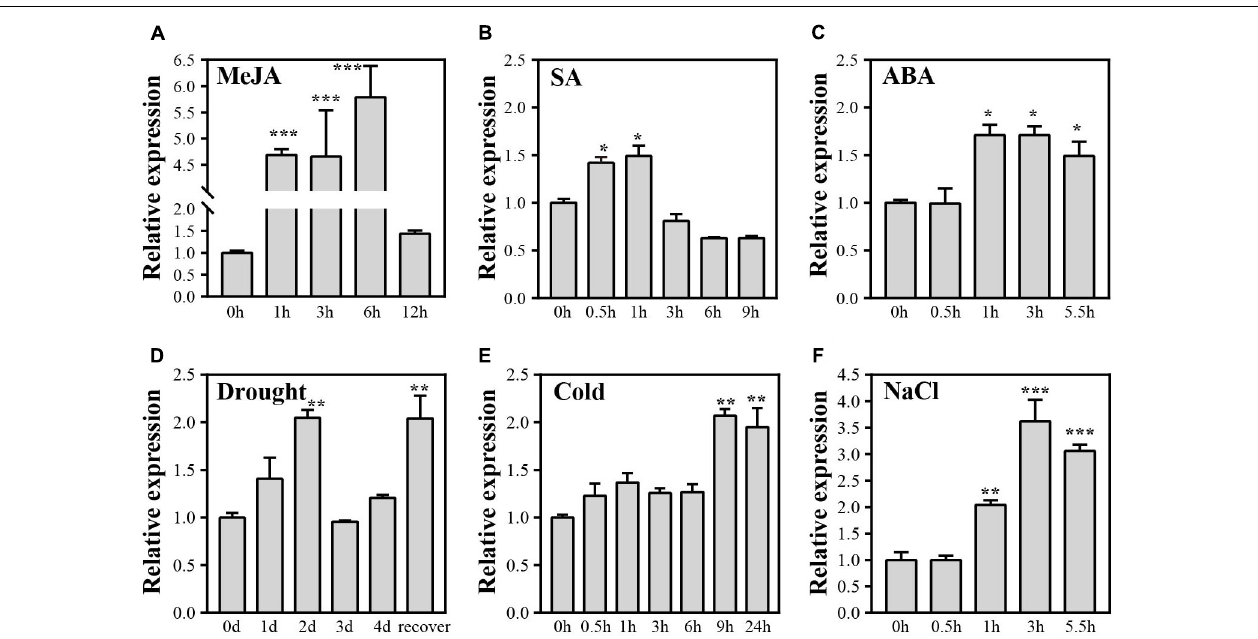
FIGURE 1 | Expression levels of OsJAZ1 under various abiotic stresses and phytohormone treatments. (A–F) Seedlings at the four-leaf stage were subjected to treatment with drought stress, NaCl (200 mmol/L), cold (4 ◦ C), ABA (100 µ mol/L), MeJA (100 µ mol/L), and SA (100 µ mol/L), respectively. Error bars represent the SE of three replicates. Significance was determined by Student’s t -test ( ∗∗∗ P < 0.001, ∗∗ P < 0.01, ∗ P <